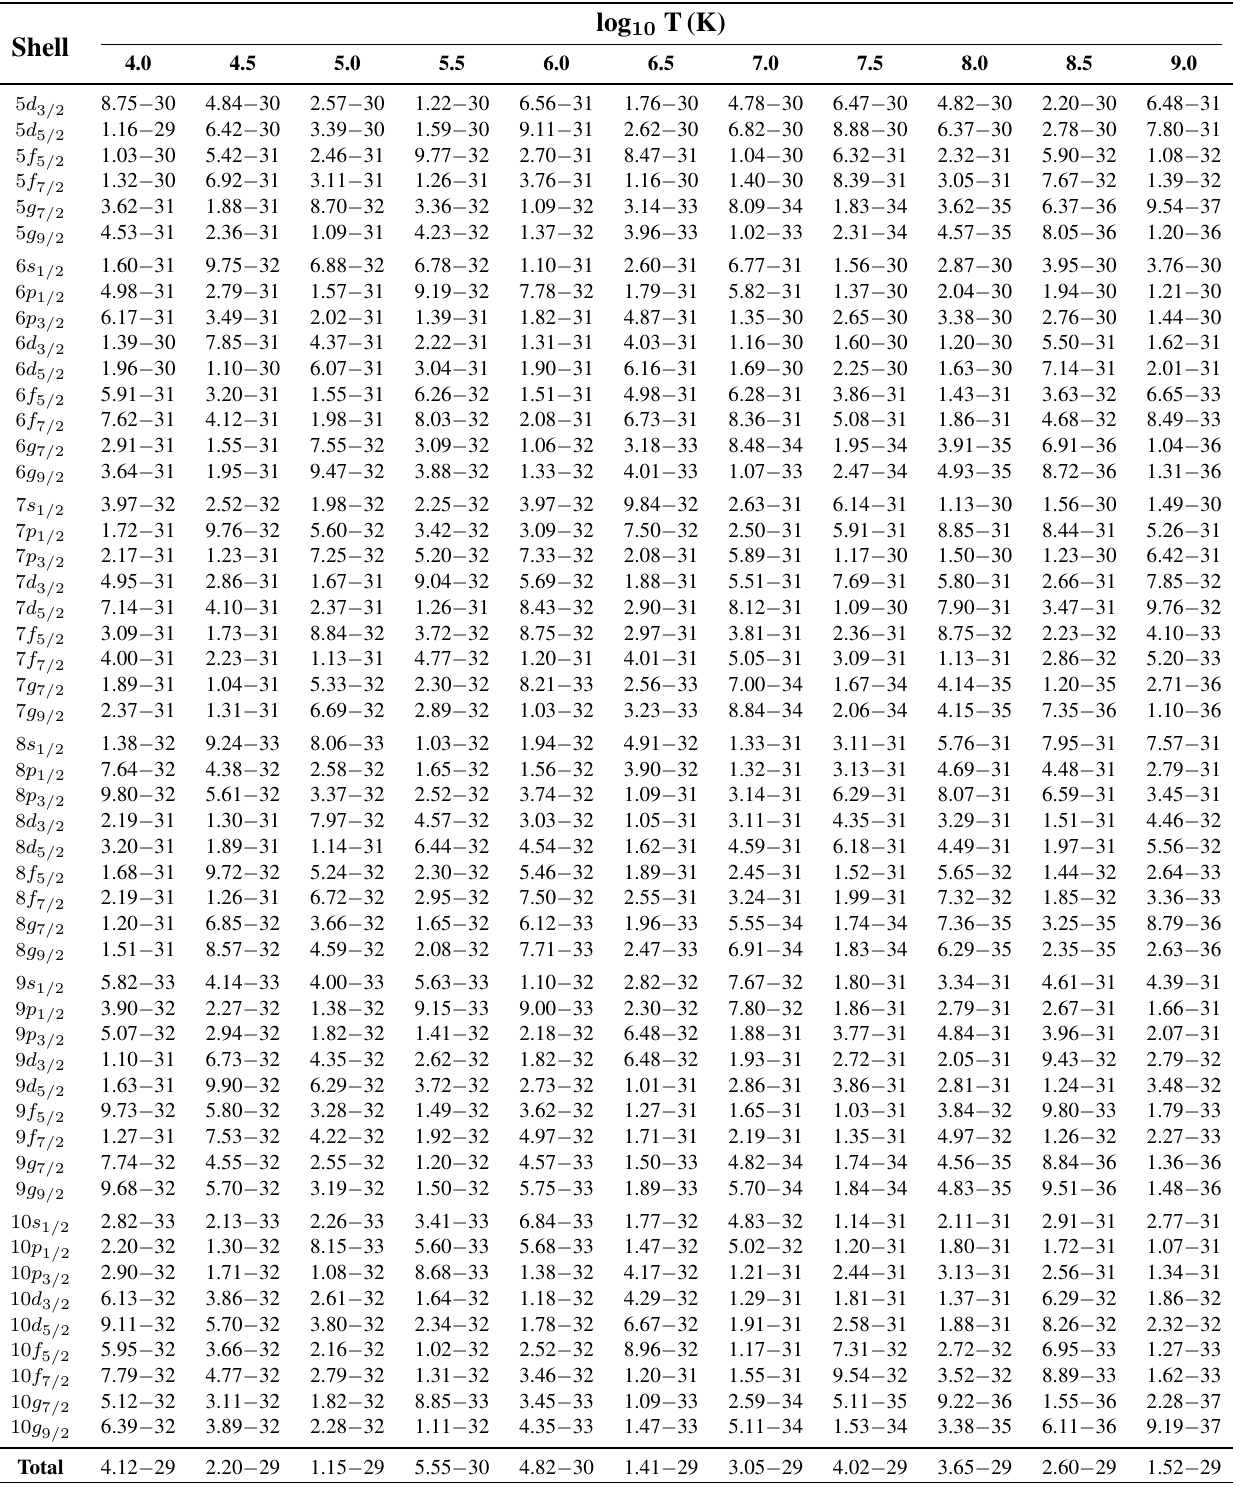
Table A2. Radiated power loss rate coefficients for W 6+ in Watts × cm 3 . Presented for a value to its right is the decimal order, e.g., 8.75–30 = 8.75 × 10 − 30 .